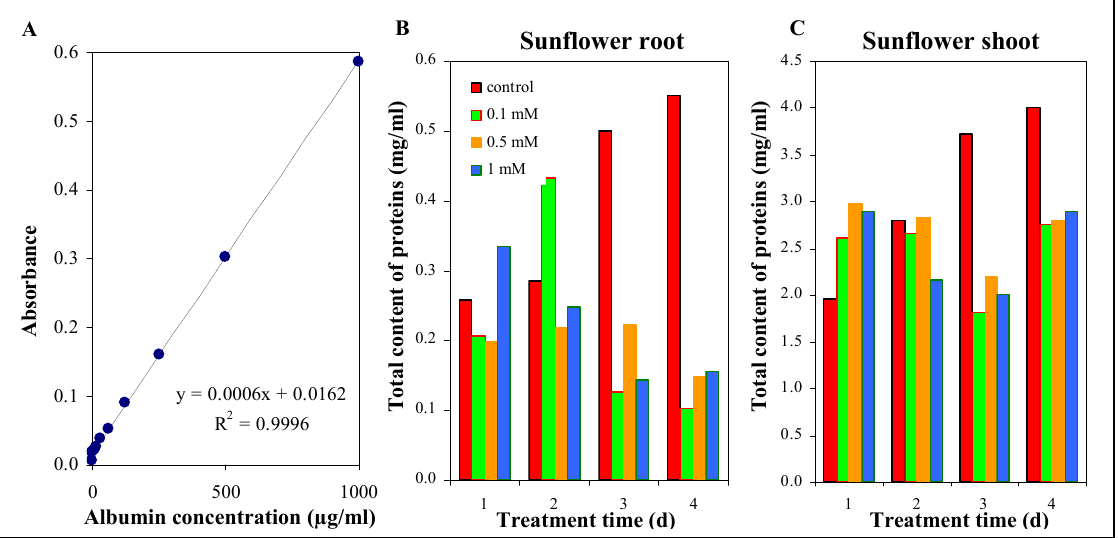
Figure 9. Total content of proteins soluble in water determined spectrometrically using biuret reaction. The dependence of signal height on albumin concentration ( A ). Total content of proteins in root ( B ) and shoots ( C ) of sunflower plants exposed to silver(I)